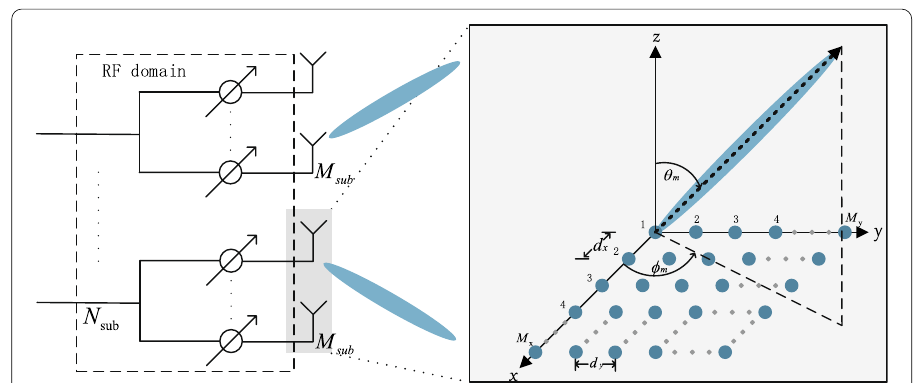
Fig. 1 The array structure of multiple wideband phased arrays at the BS side, and the coordinate system of each